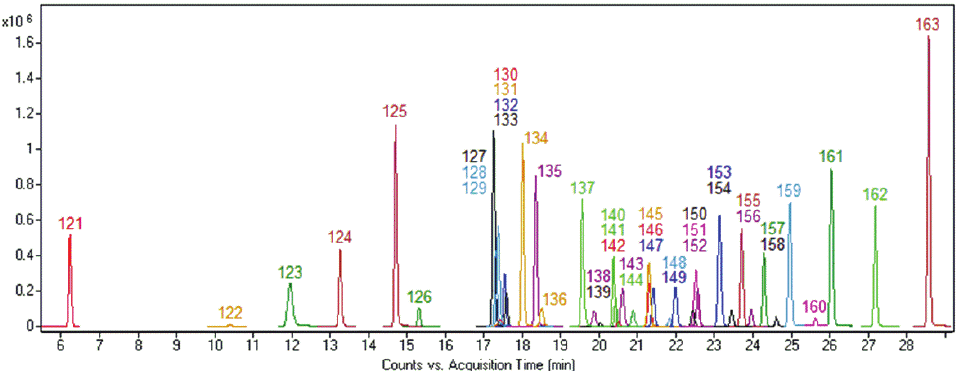
Figure 3. Chromatograms for the quantifier MRM transitions of BDZ/antidepressants, with a reten-